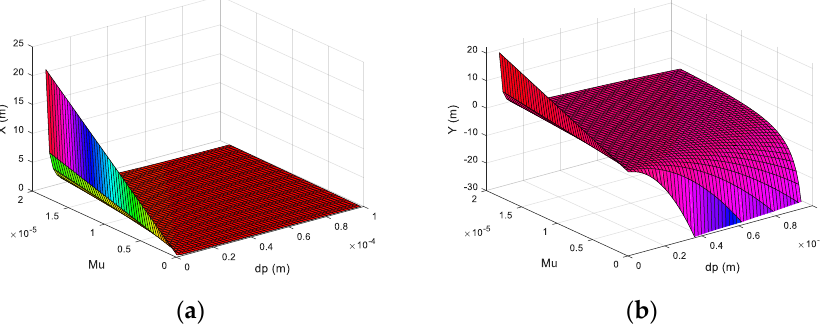
Figure 8. Dynamic displacement response of horizontal electric field strength and particle diameter: ( a ) X -axis displacement response; ( b ) Y -axis displacement response.